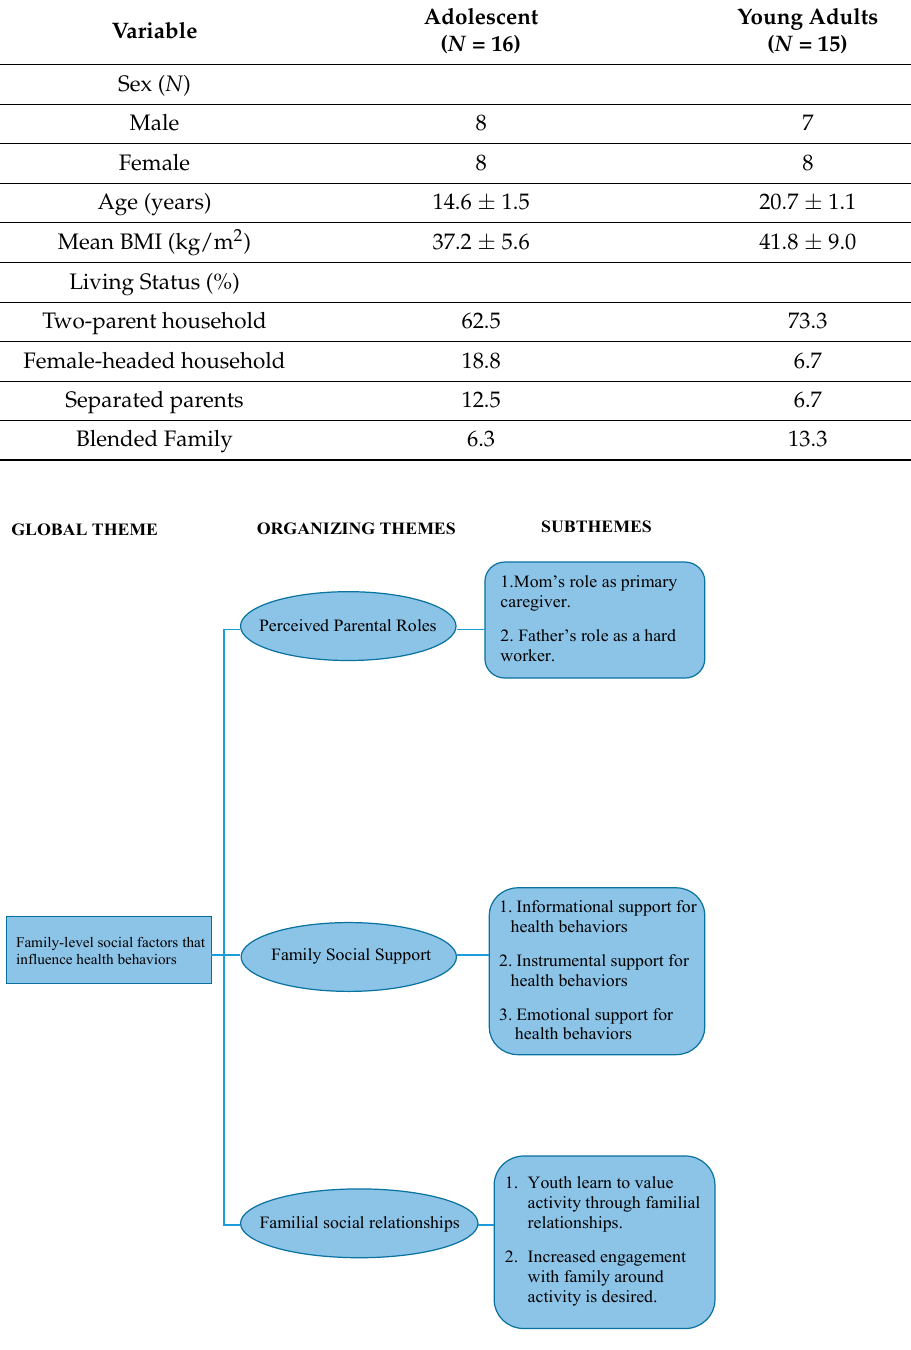
Figure 1. Identified themes and subthemes . Table 2. Participant characteristics.